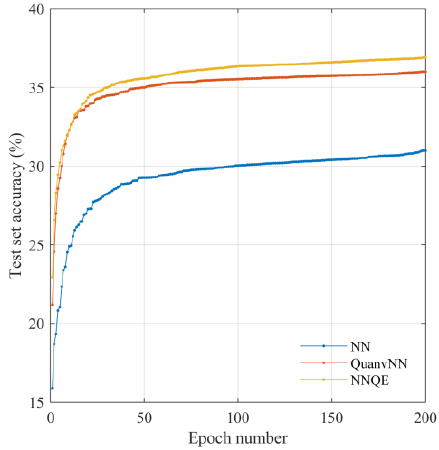
Figure 9. Test set accuracy against CIFAR-10 dataset images.